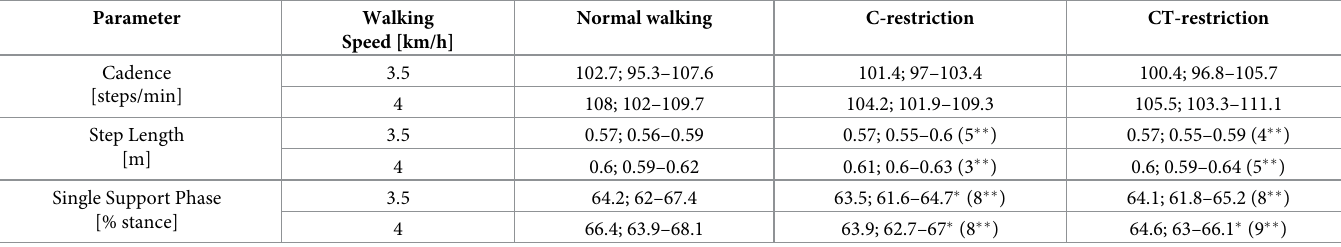
Table 1. Gait timing between